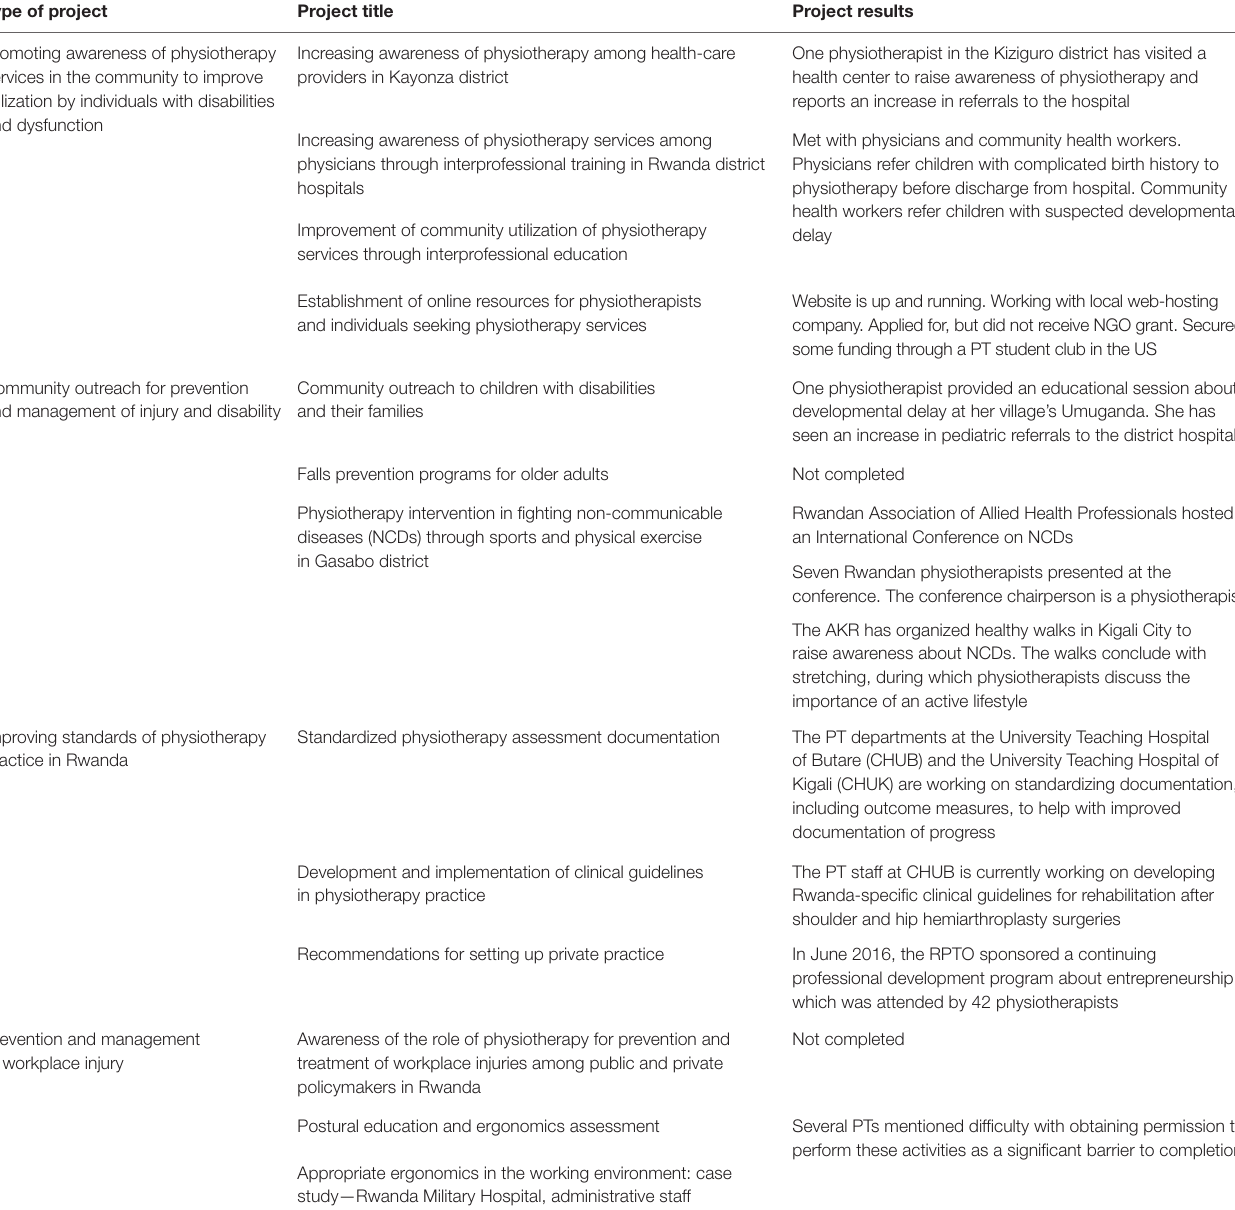
taBle 1 | Leadership institute projects and